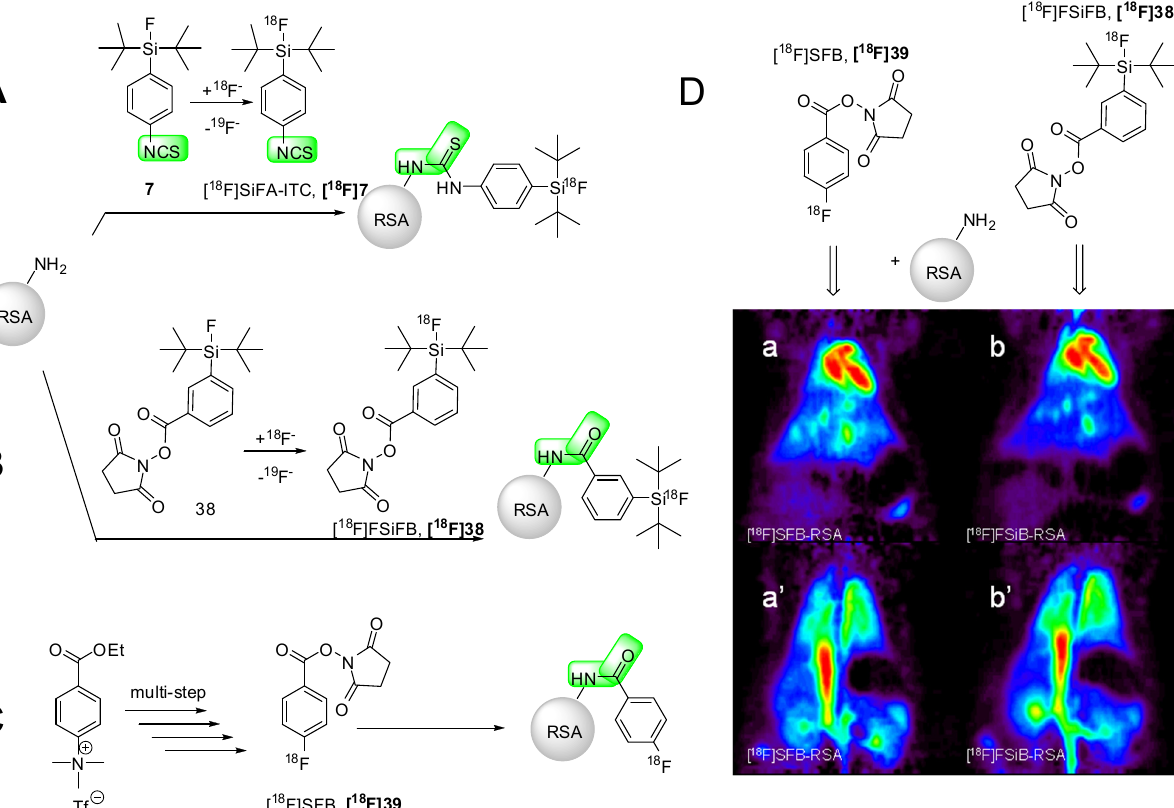
Figure 14 . Radioactive labeling of RSA and other proteins (not shown) using ( A ) [ 18 F]SiFA-isothiocyante ([ 18 F]SiFA-ITC, [ 18 F]7 ), ( B ) [ 18 F]SiFB and ( C ) the non- silicon containing most frequently applied protein labeling synthon [ 18 F]SFB. ( D ) The